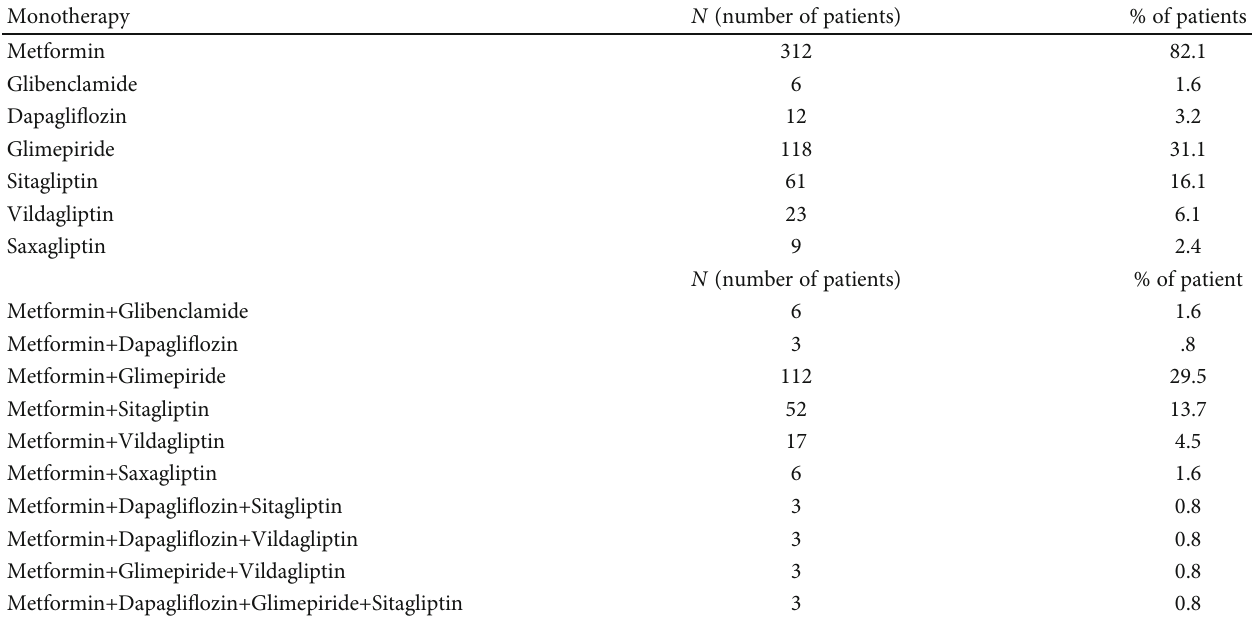
Table 2: Medications history and manner of prescribing of antidiabetic drugs.